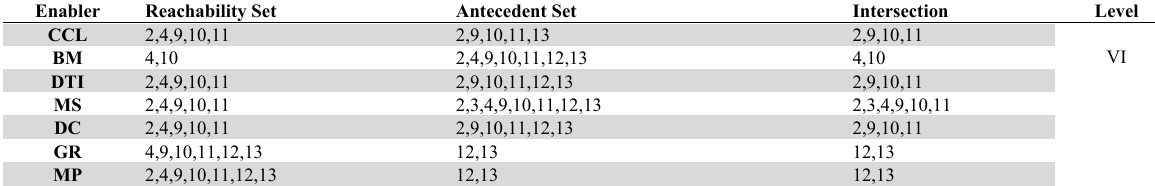
Level partitioning Iteration 6